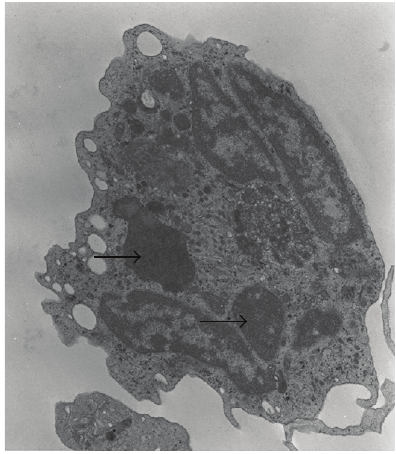
Figure 3: Electron microscopy of a neutrophil granulocyte of our patient. The arrows show abnormal large cytoplasmic